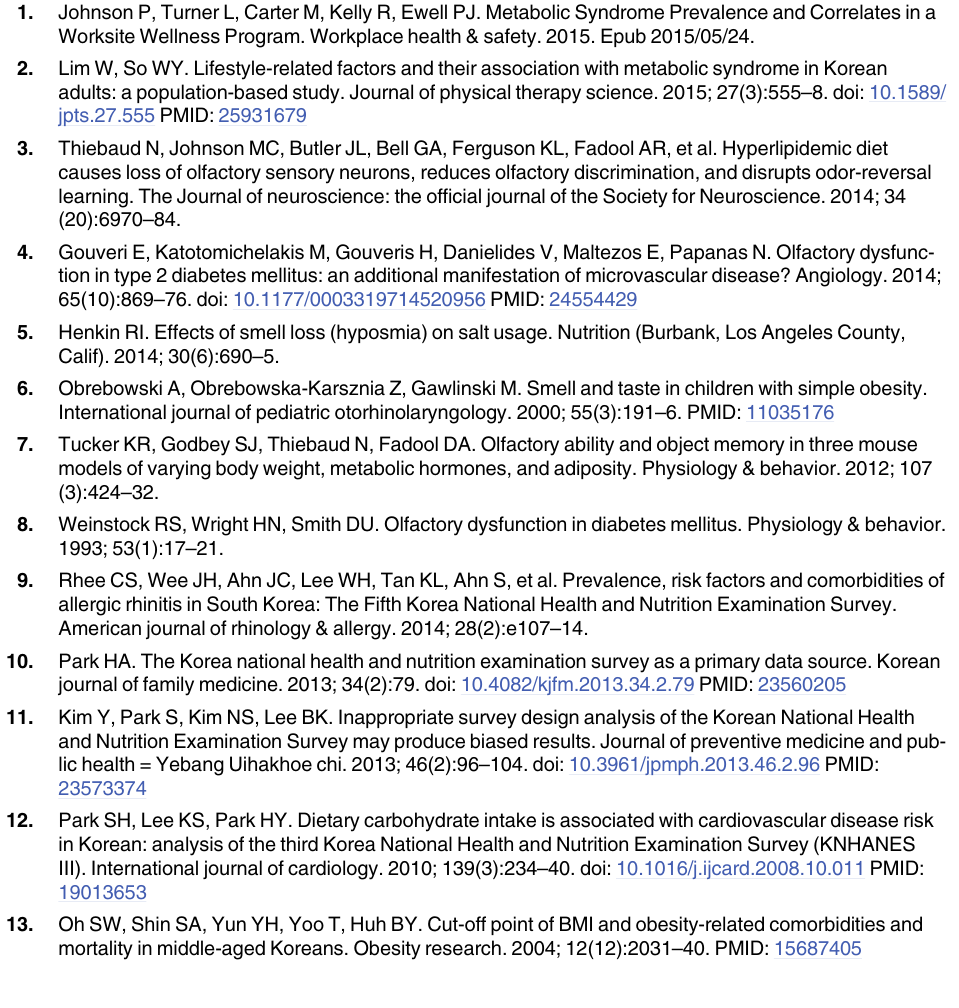
S1 Table. Korea National Health and Nutrition Examination Survey Questionnaire item assessing olfactory